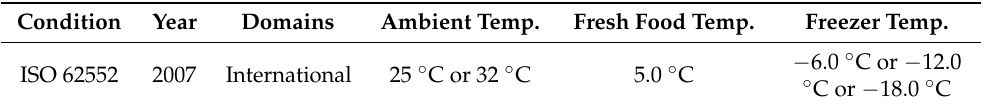
Table 1. Standard ISO test